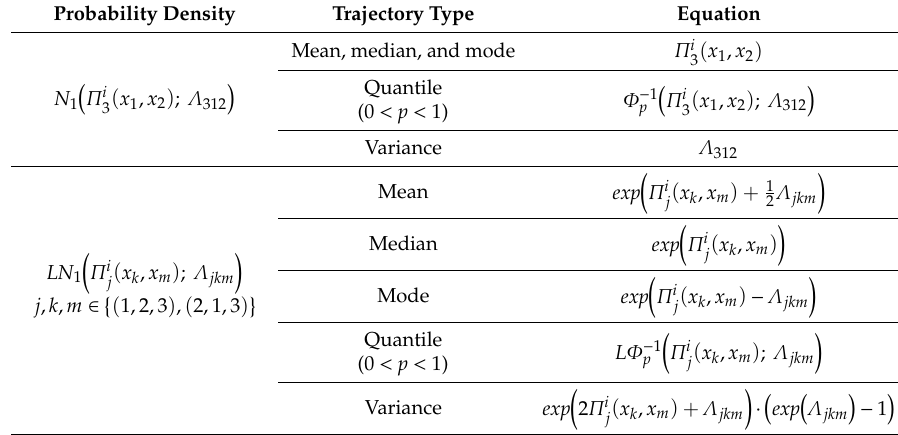
Table 10. Stationary conditional mean, median, mode, p -quantile (0 < p < 1), and variance trends with two